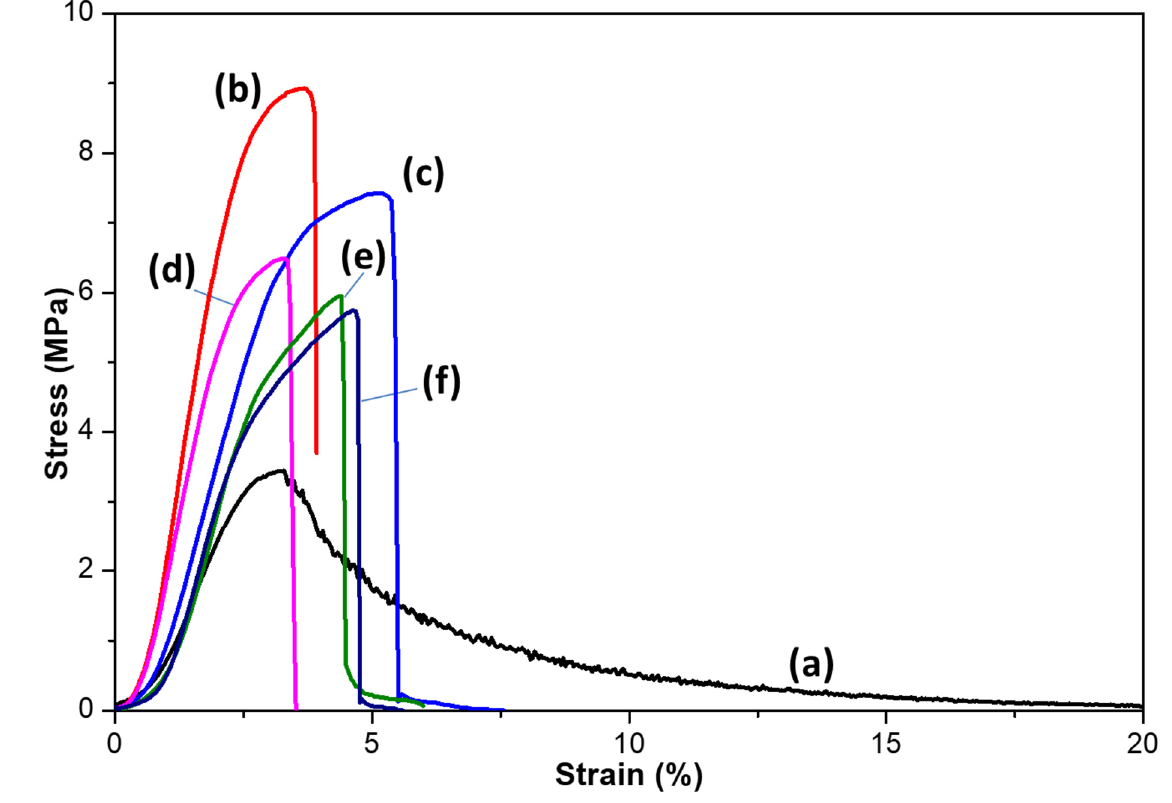
Figure 5. Stress–strain profiles of ( a ) CA, ( b ) CL, ( c ) OEO-CL, ( d ) Ag-CL, ( e ) Ag-OEO5%-CL, and ( f ) Ag-OEO10%-CL.